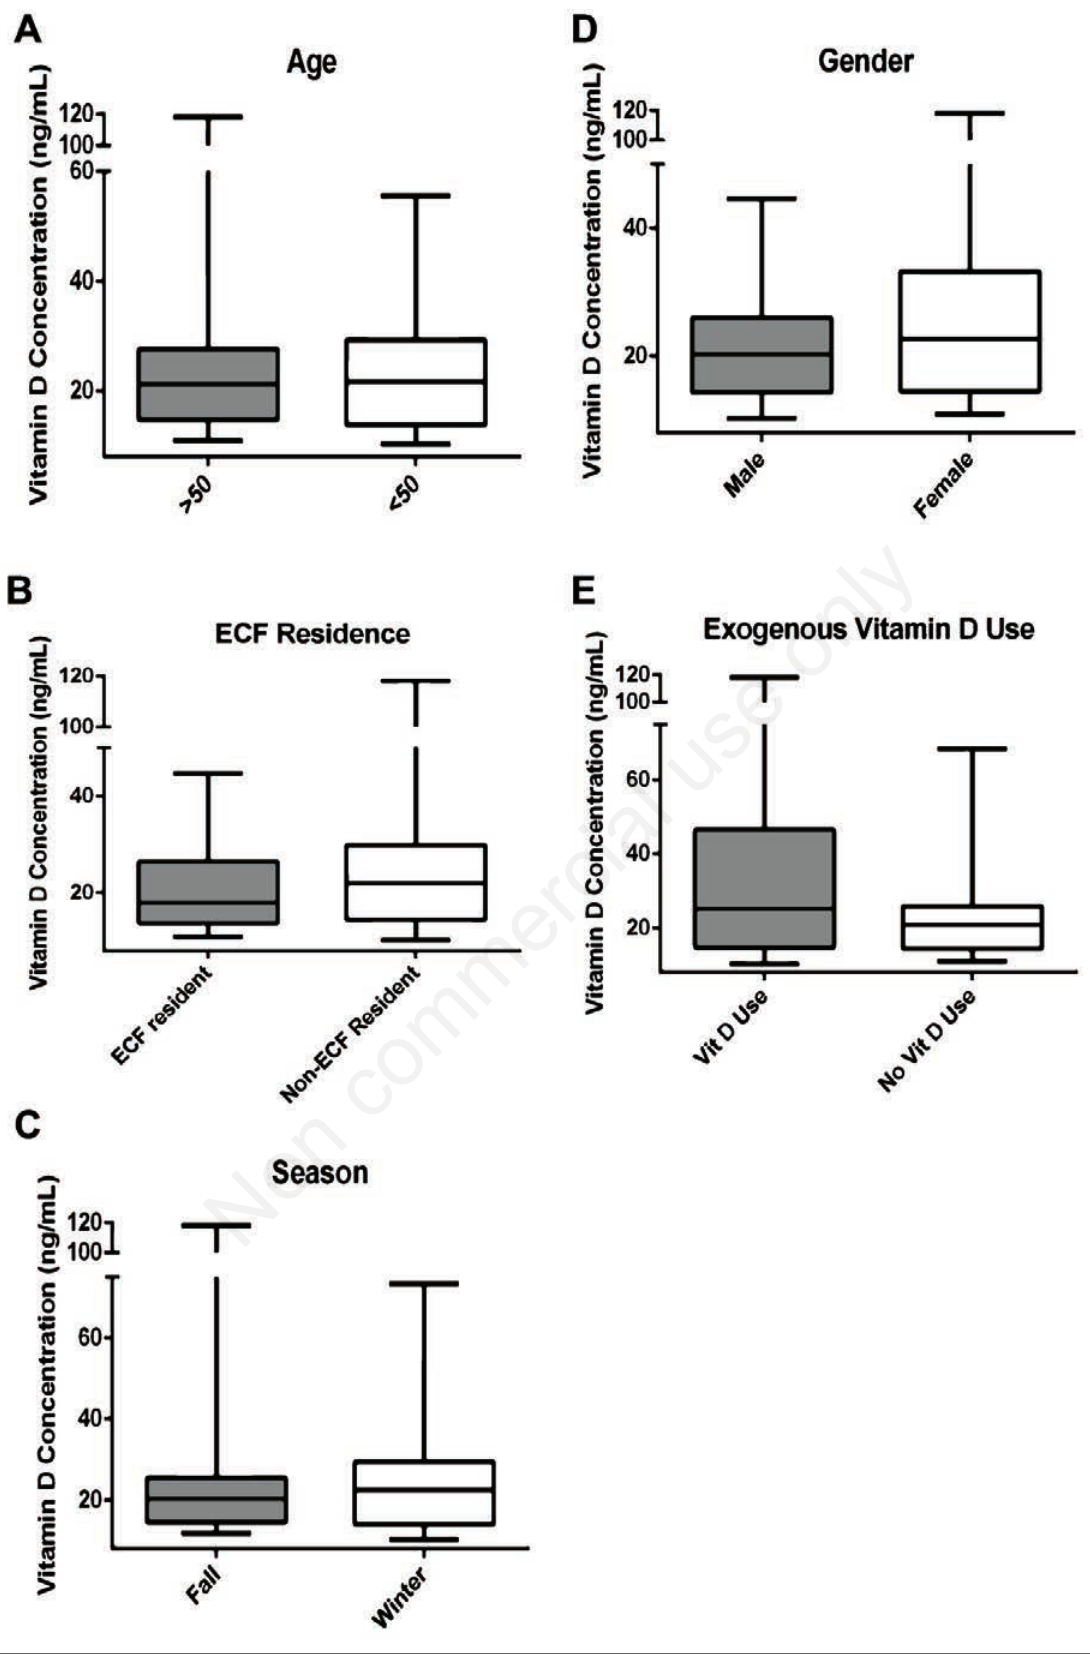
Figure 1. Serum 25-hydroxyvitamin D subgroup analysis. This figure compares mean serum 25-hydroxyvitamin D levels categorized by: A) age, B) extended care facility (ECF) residence, C) season, D) gender and E) exogenous vitamin D supplementation. Only exoge- nous vitamin D supplementation demonstrated statistically significant higher levels of mean 25-hydroxyvitamin D